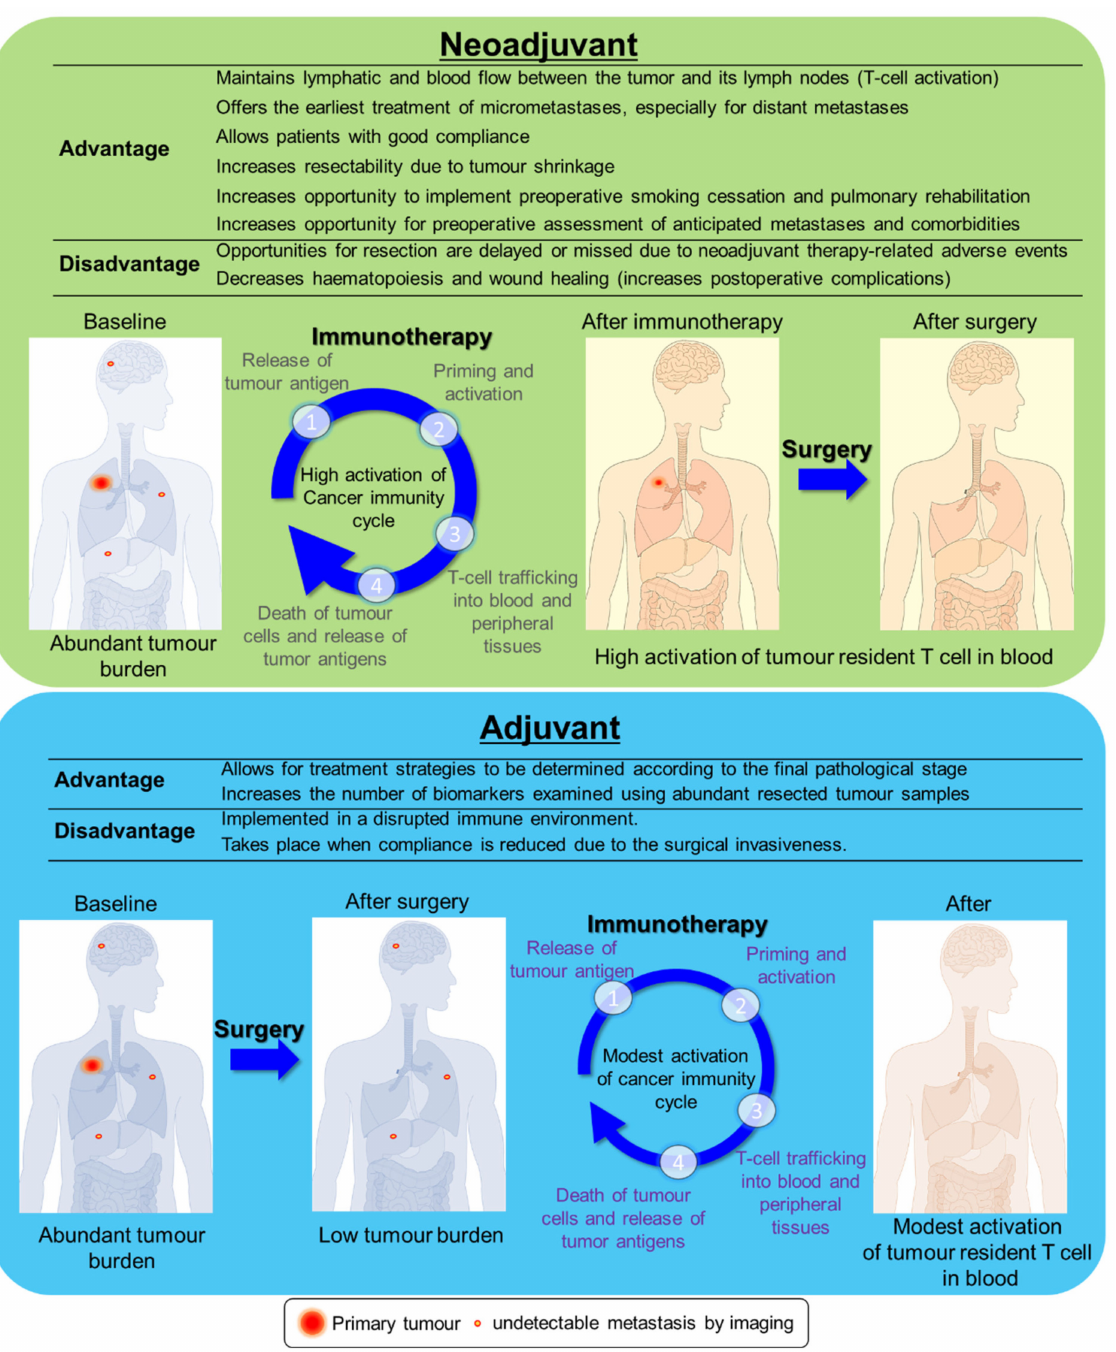
Figure 1. Comparison of neoadjuvant and adjuvant immunotherapies. Neoadjuvant immunotherapy is performed under an abundant tumour burden, which may promote high activation of cancer immunity (upper panel). In contrast, adjuvant immunotherapy is performed under a low tumour burden, but immunotherapy may induce enough efficacy to only control residual disease (lower